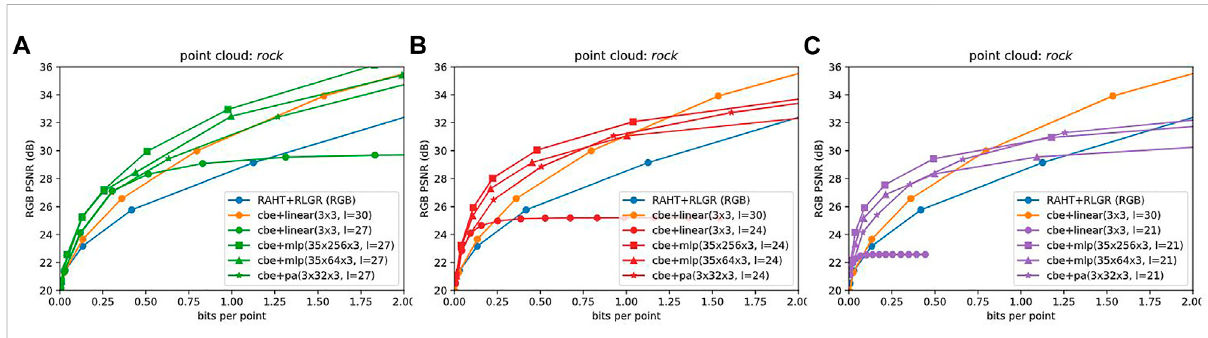
FIGURE 6 Coordinate Based Networks, by target level. (A – C) each show mlp(35 × 256 × 3) , mlp(35 × 64 × 3) , and pa(3 × 32 × 3) CBNs, along with baselines, at levels 27, 24, 21. More complex CBNs outperform less complex. Higher levels are better for higher bit rates.